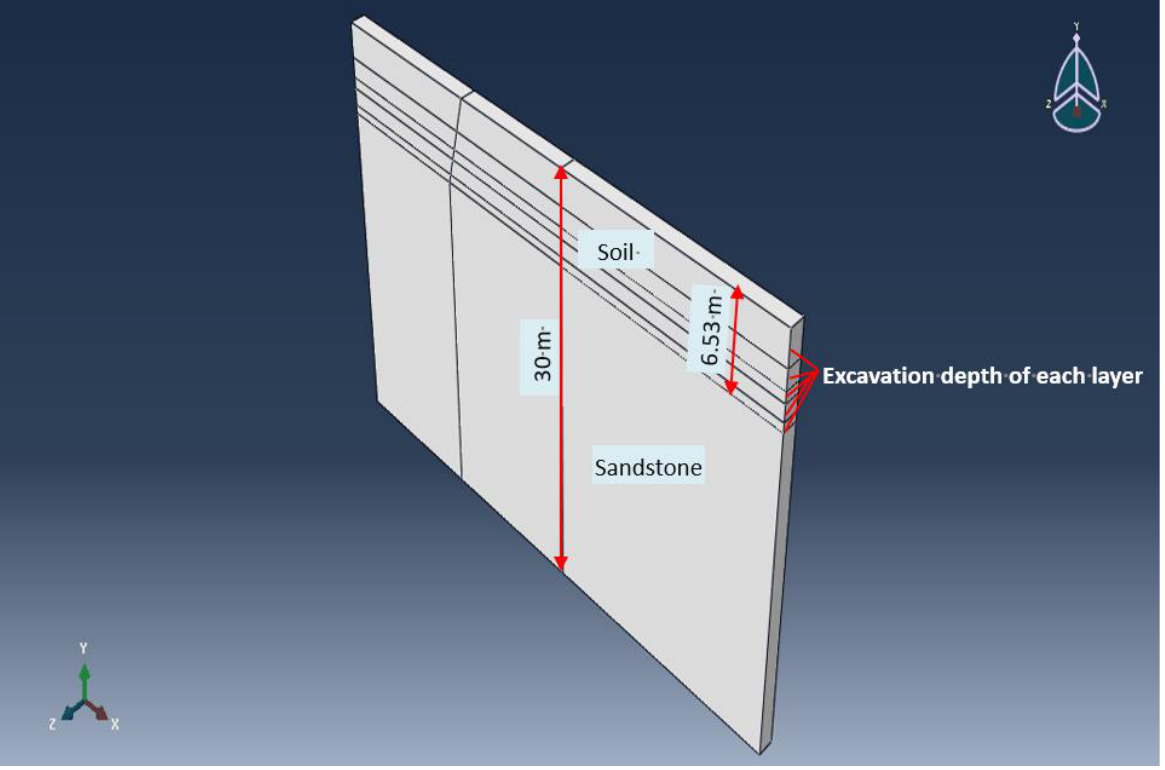
Figure 11. Numerical model.